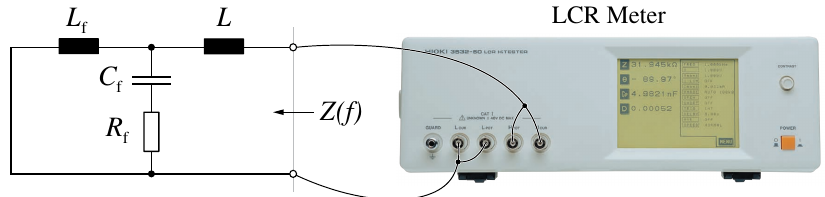
Figure 14. Experimental setup utilized to measure the value of Y = 1/ Z (see Figure